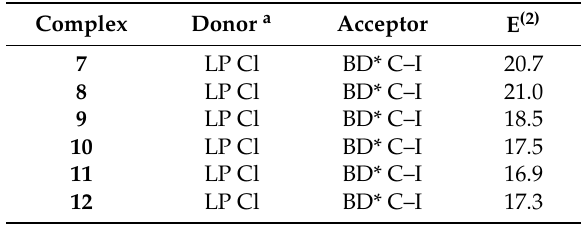
a LP, BD* stand for lone pair and anti-bonding orbital,